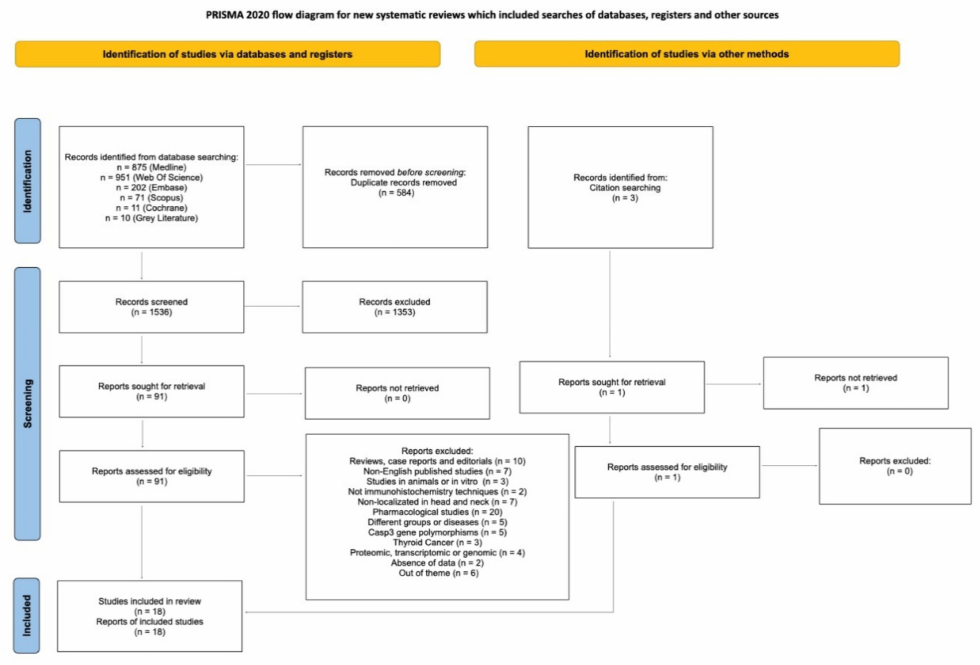
Figure 2. Flow diagram of literature search. Diagram according to Preferred Reporting Items for Systematic Reviews and Meta-Analyses (PRISMA)